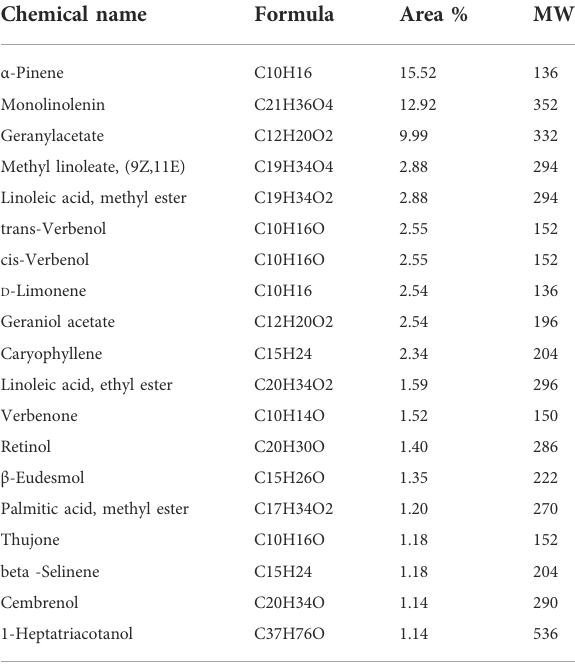
TABLE 1 Major composition (% area ˃ 1) of B. sacra essential